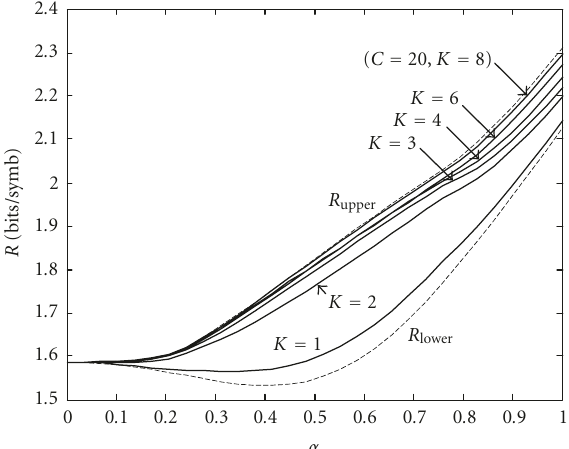
Figure 6: Achievable rate (8) with intercell conferencing and intracell TDMA versus the intercell gain α. The lower bound (4) and upper bound (6) are also shown for reference ( (cid:4) P = 3dB, C = 10, J = 1)